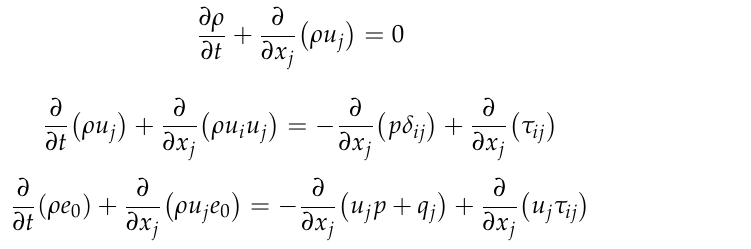
Figure 6. Calculation of the airflow reduction based on the measured data of static pressure.